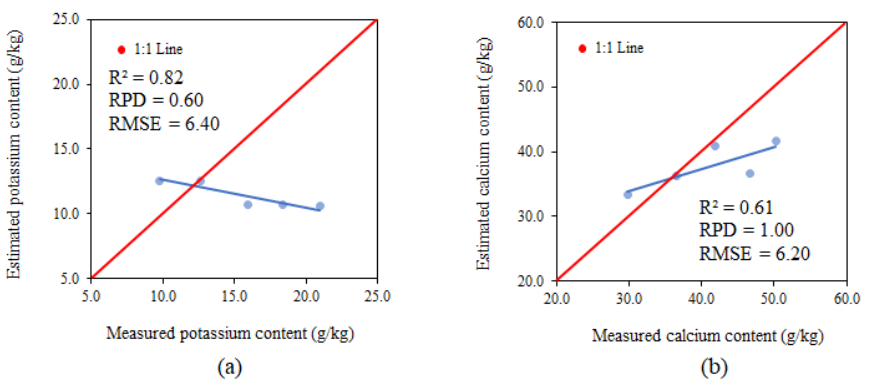
Figure 12. Relationships between the measured and estimated levels of K ( a ) and Ca ( b ) at phenological stage R9.